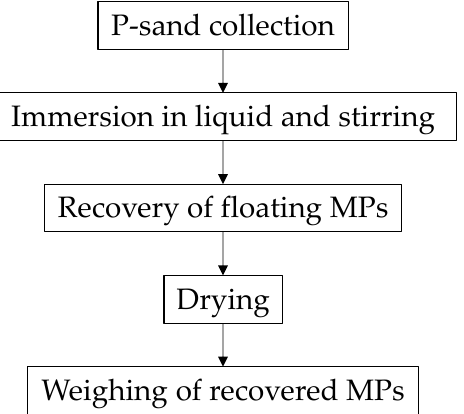
Figure 2. Input of P-sand and floating of MPs with a density that is lower than the liquid.